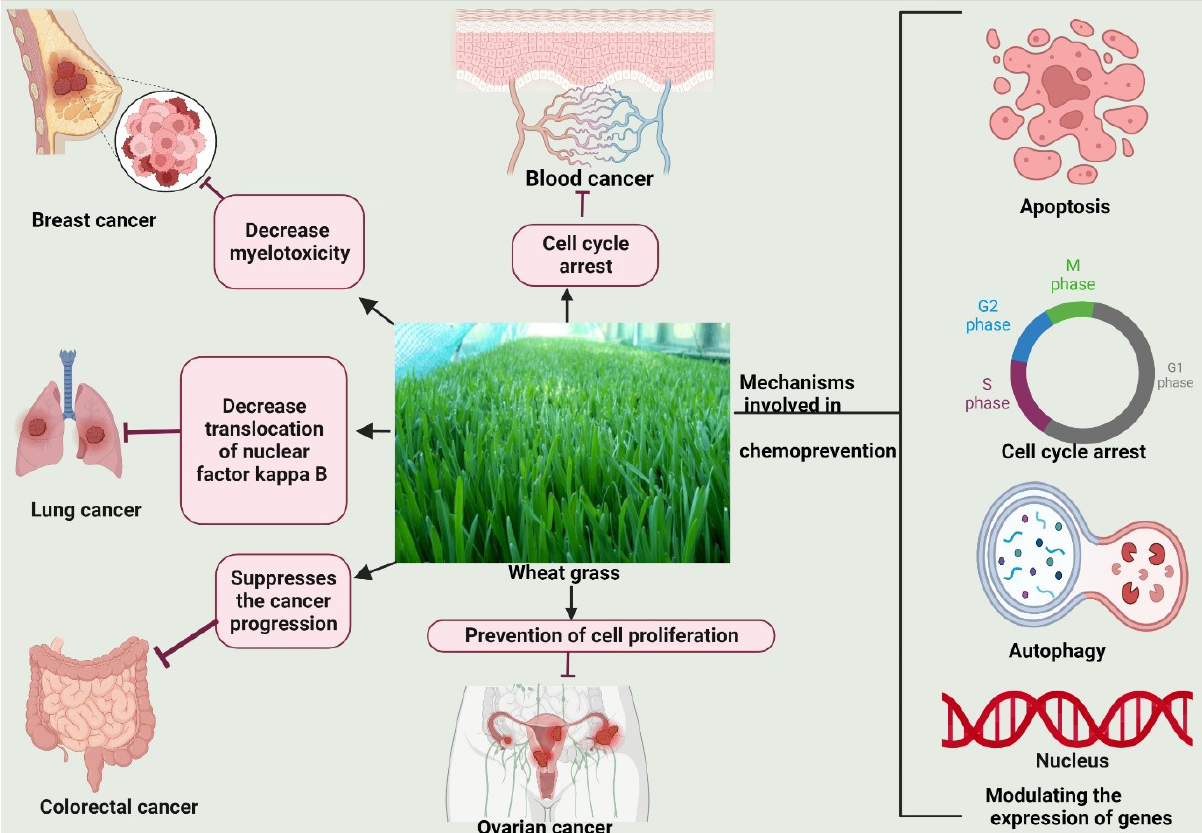
Figure 1. Graphical representation of wheatgrass in